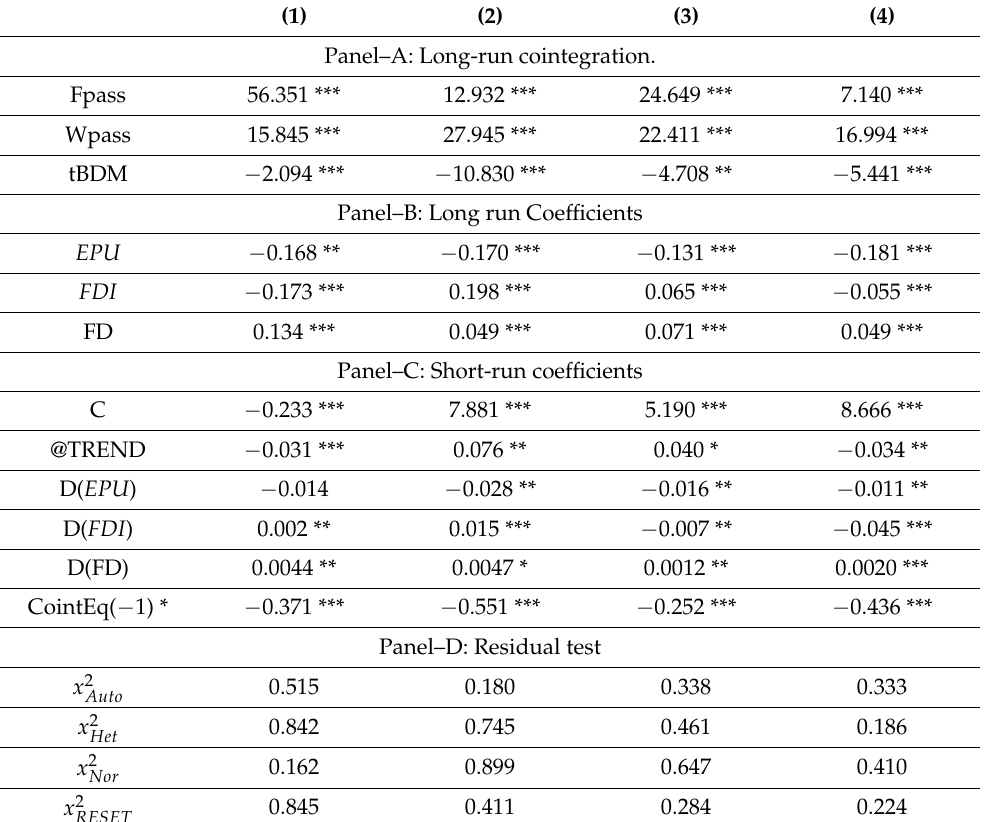
Table 8. Results of ARDL estimation for renewable